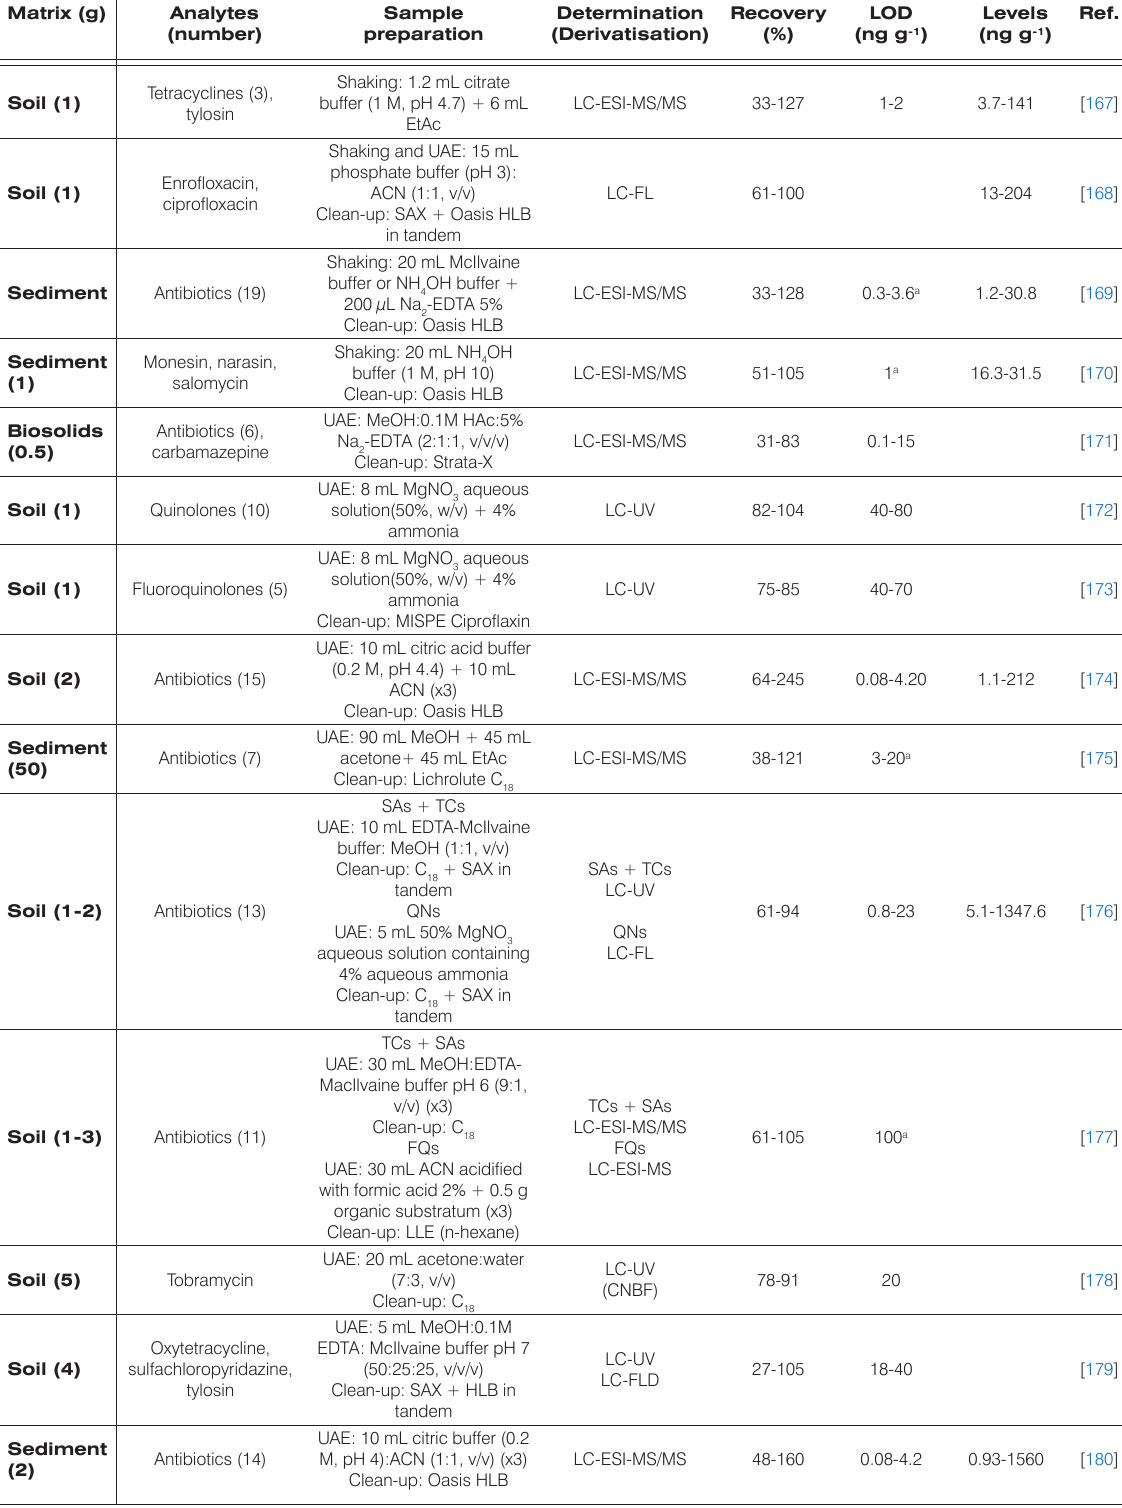
Table 7. Analysis of antibiotics in environmental solid